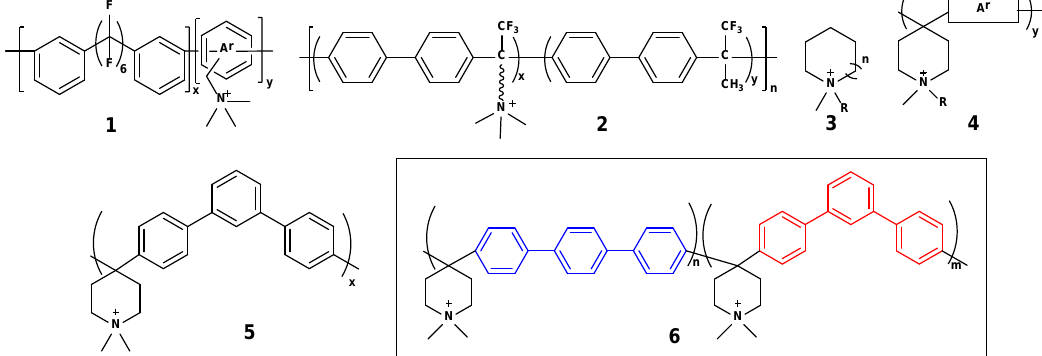
Figure 1. Structure of polyarylene backbone-type anion exchange membranes (AEMs) as poly(arylene perfluoroalkylene)s ( 1 ) [26] and poly(biphenyl alkylene)s ( 2 ) [27], hetero-cycloaliphatic-type